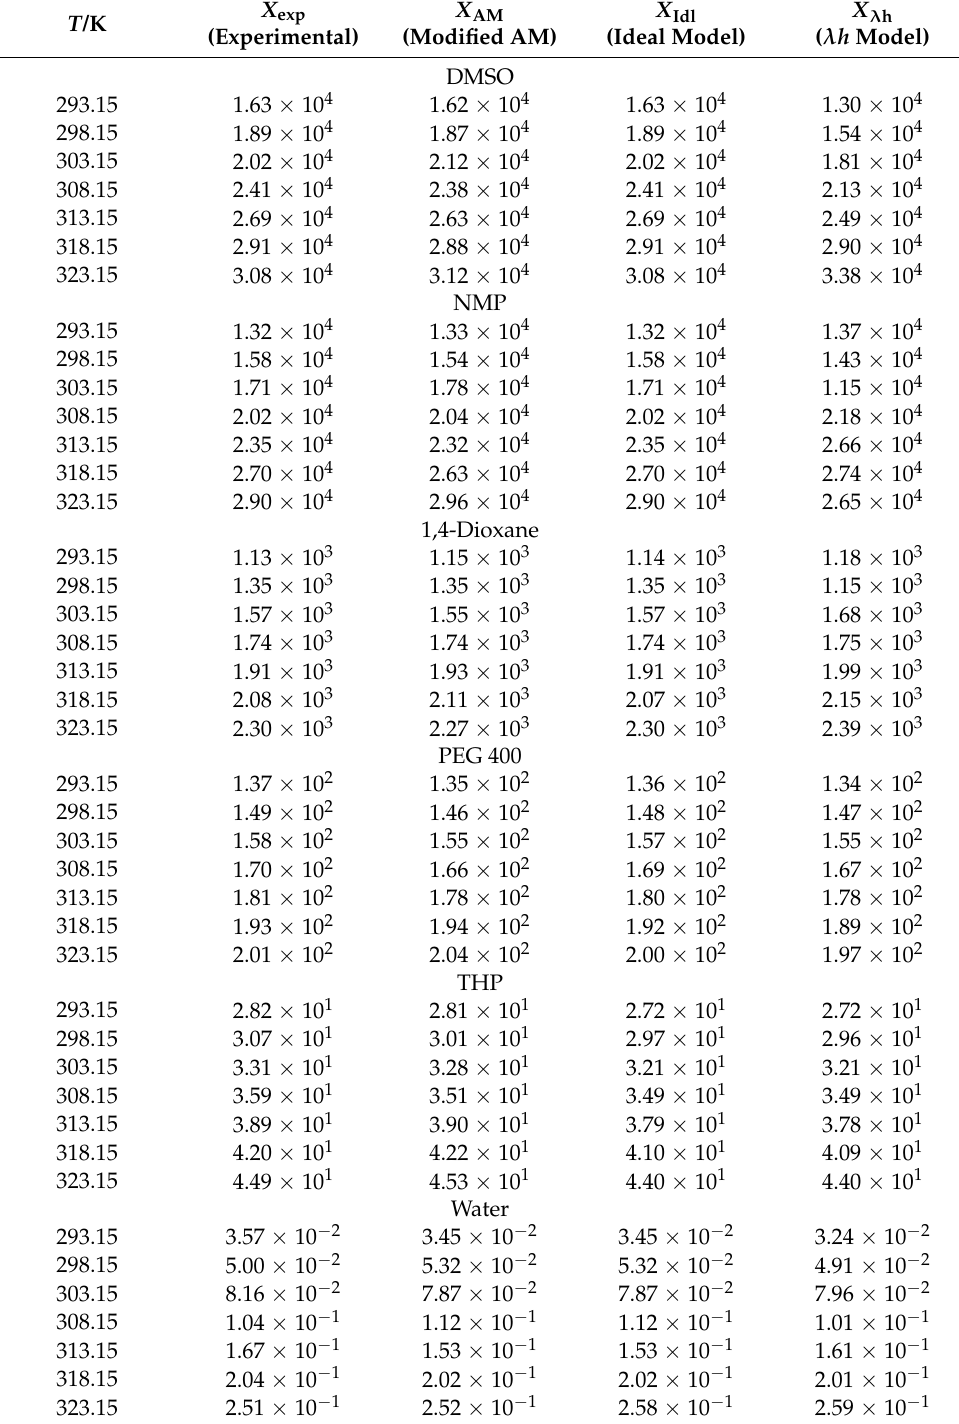
Table 1. Experimental and calculated mole fraction solubility of the GLN in organic solvents at T = (293.15~323.15)